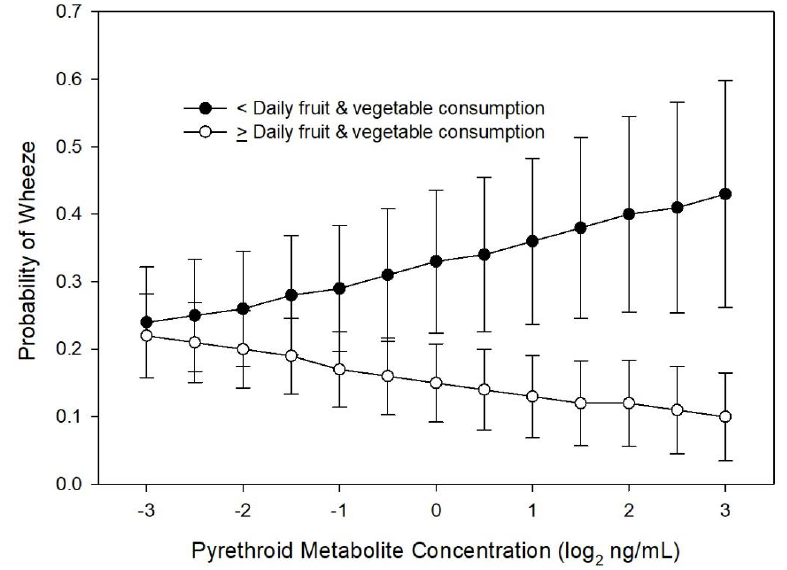
Figure 1. Probability of child wheeze at age 8 years related to maternal pyrethroid (3-Phenoxybenzoic acid, 3PBA) metabolite concentration and maternal daily fruit and vegetable consumption during pregnancy ( n =